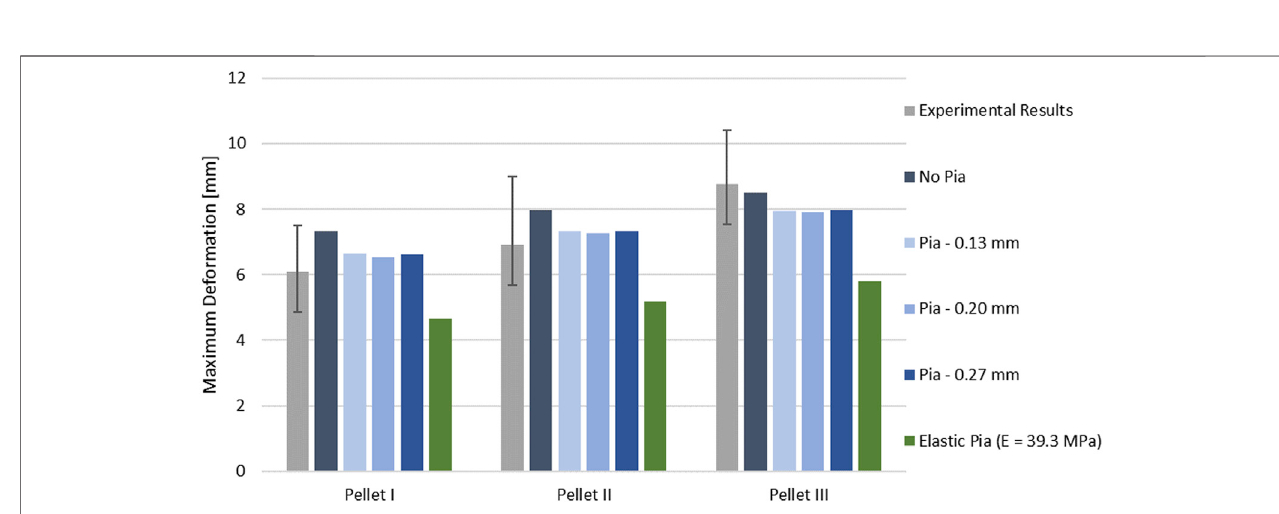
deformation of the SCP complex with elastic pia mater was lower by 38.5% compared to the experimental mean value ( Figure 10 ).